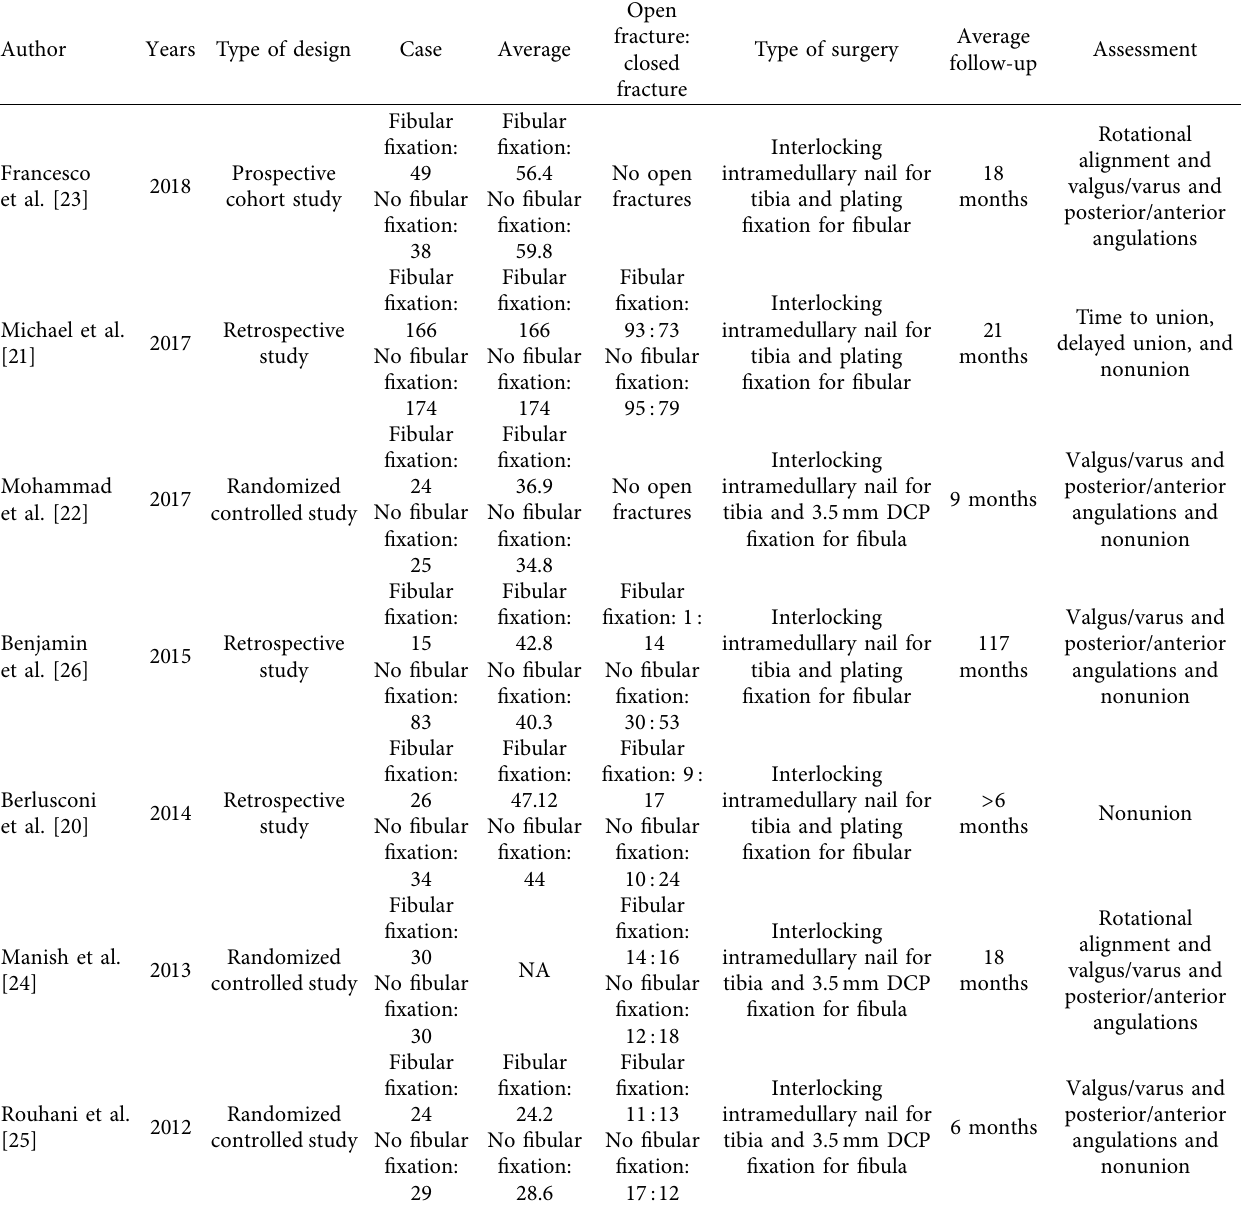
Table 1: The main characteristics of selected